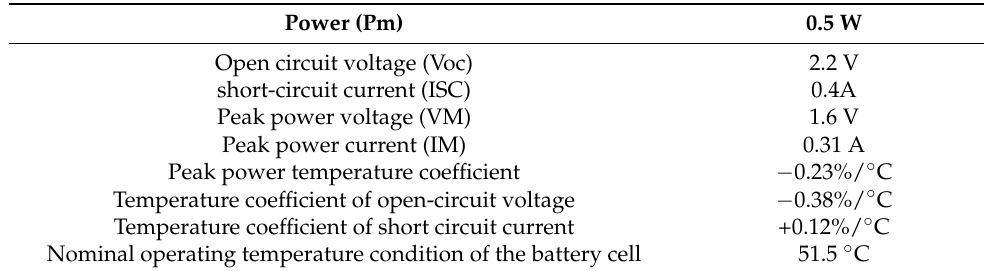
Figure 2. Diagram of the composite structure of film battery and PVC membrane: ( a ) loading along the fiber direction, ( b ) loading at an angle of 45 degrees to the fiber. Table 1. Technical parameter for thin-film batteries.